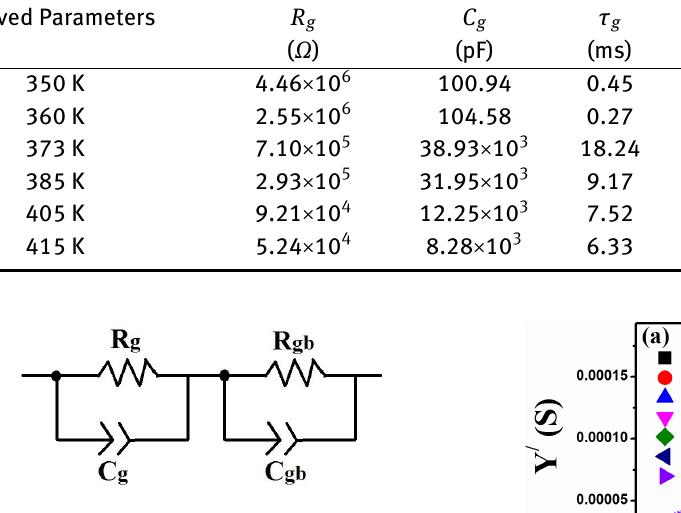
Figure 5: The equivalent circuit diagram (R-C circuit) for the Impedance spectra.